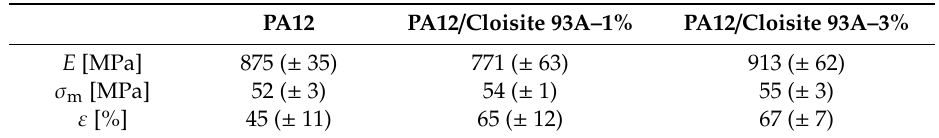
Table 6. The average values with standard deviations in brackets of mechanical properties for PA12 and nanocomposites.